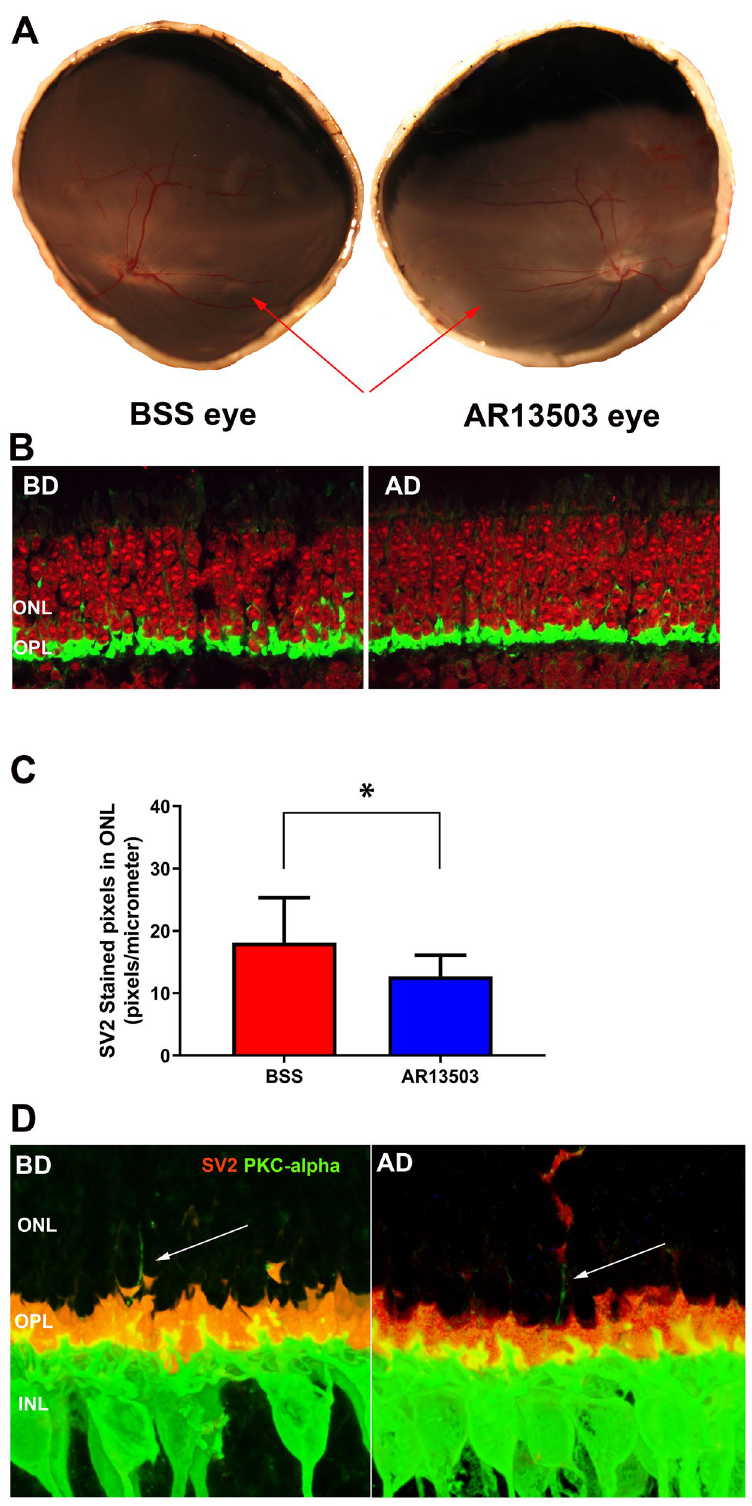
Figure 4. Morphological results 2 days after retinal detachment. (A) Detachments have spontaneously reattached (red arrows). ( B) Retraction in the saline-treated eye detached area (BD) and the drug-treated eye, detached area (AD). Retina labeled for synaptic vesicle protein (SV2, green) and nuclei (propidium iodide, PI, red). ( C) Axonal retraction was significantly reduced by 29.7% in AR13503-treated eyes compared to the eyes that received BSS alone (n = 6 animals, *p = 0.04, using 60 images/eye, + /- SD). Attached and detached areas of each eye were combined for this analysis (AC + AD vs. BC + BD). Data on the individual areas are reported in the Results. ( D) Sprouting of bipolar cells. Retinae labeled for synaptic vesicle protein (SV2, red) and rod bipolar cells (anti-protein kinase C-alpha, PKC-alpha, green). White arrows indicate the fine dendritic processes of the bipolar cells extending into the outer nuclear layer (ONL). Pictures were taken of detached-spontaneously reattached areas both from BSS- (BD) and drug-treated (AD)